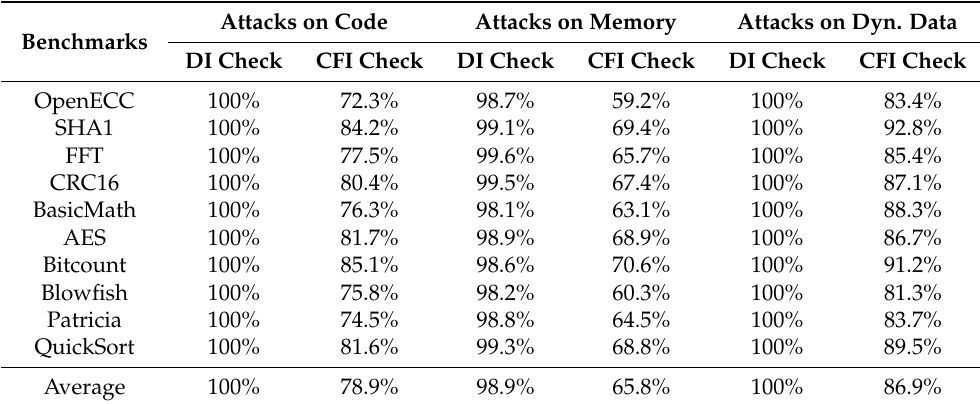
Table 4. Statistics on the detection rate of data